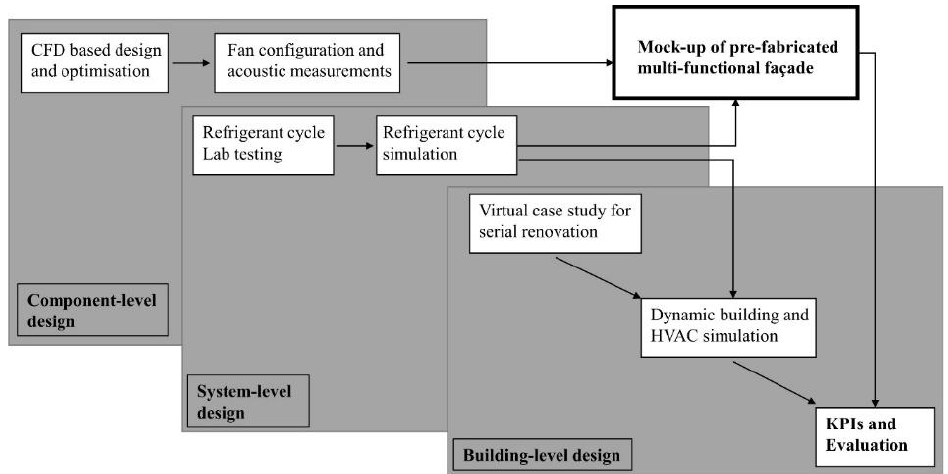
Figure 2. A holistic approach to support the development of façade integrated decentralized HPs — from component to system and to building level optimization.